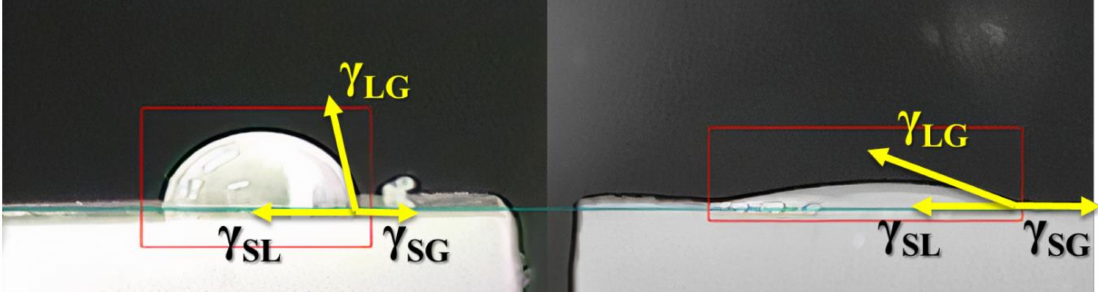
Figure 4. The behavior of the drop in contact with the surface of material before and after treatment.